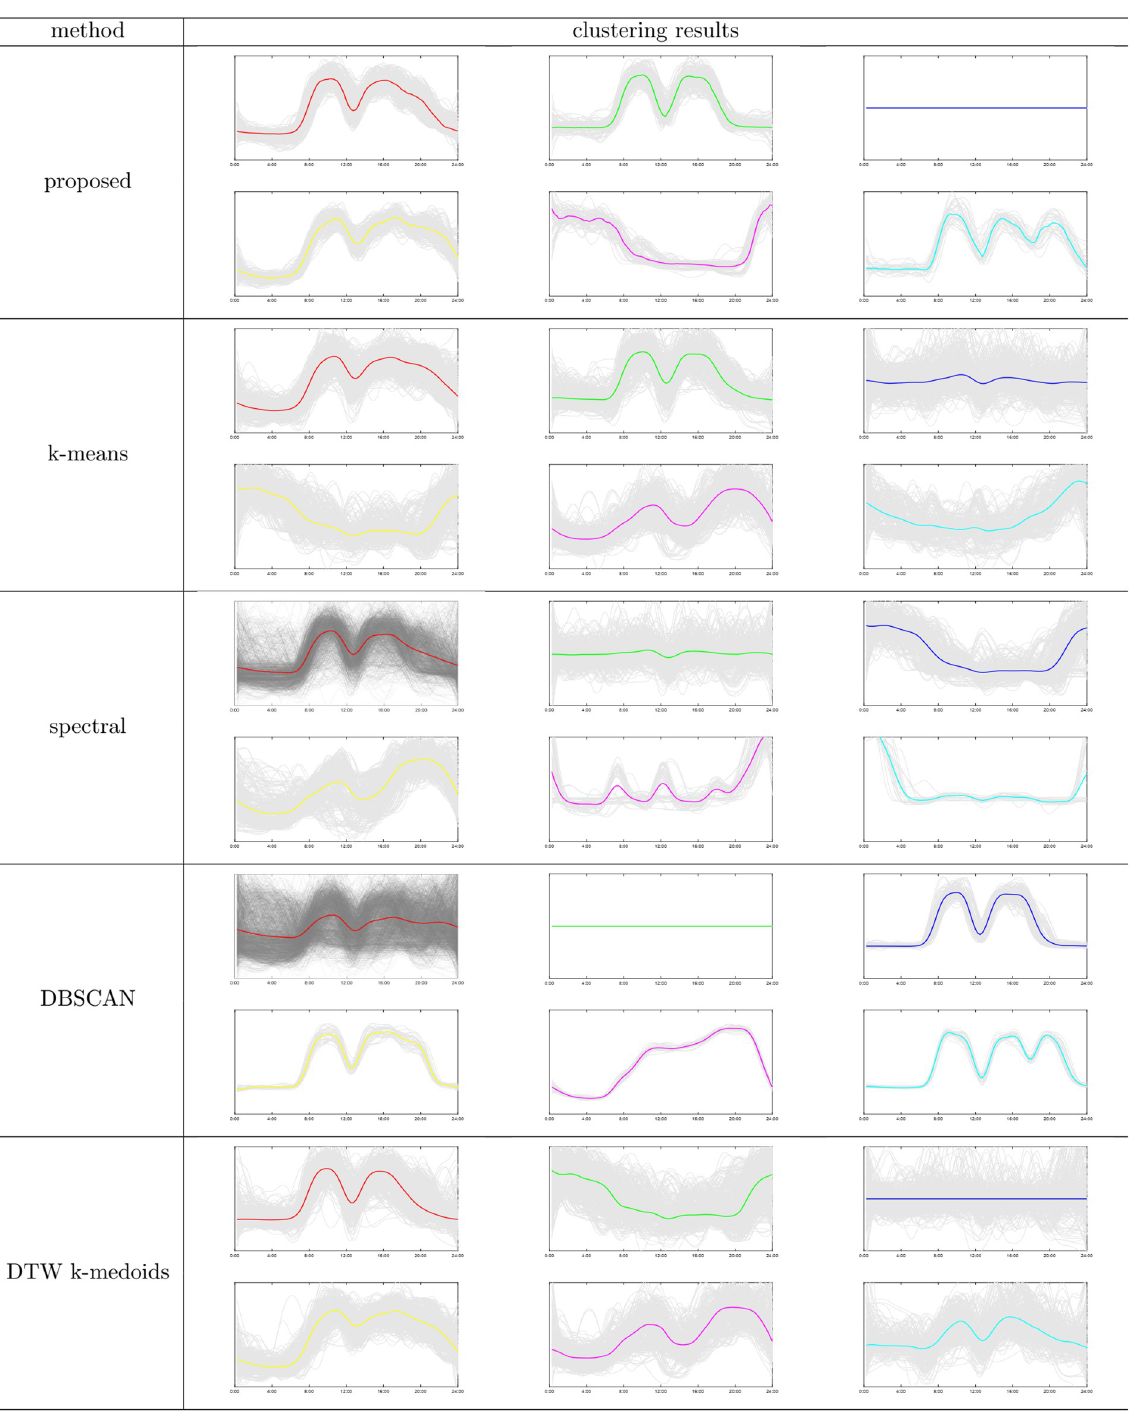
Fig 8. Clustering results of different clustering methods. Notes: The proposed method gets 6 major clusters and many tiny clusters. The tiny clusters are composed of a few members. In applications, these tiny clusters are recognized as noise. So we only present the 6 major clusters for